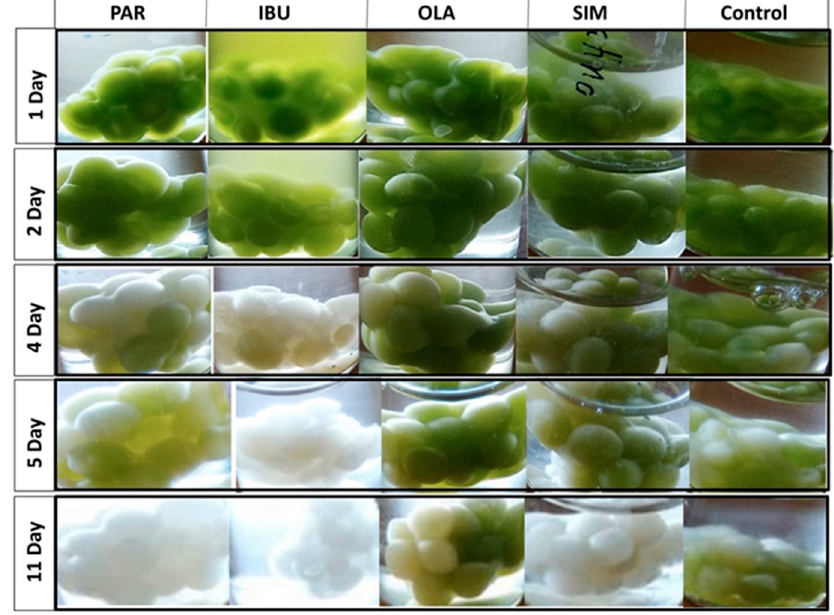
Figure 3. Immobilised Nannochloropsis sp. cells grown in f / 2 medium and PAR, IBU, SIM and OLA, separately, during 11 days of culture.